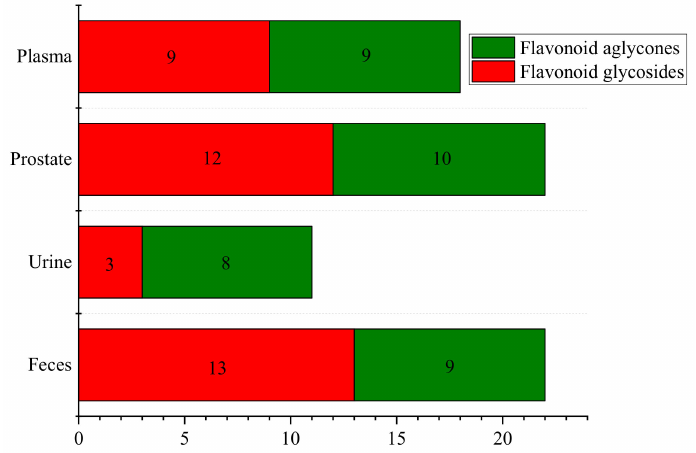
Figure 3. Strip graph of flavonoid glycosides and flavonoid aglycones in plasma, prostate, urine and